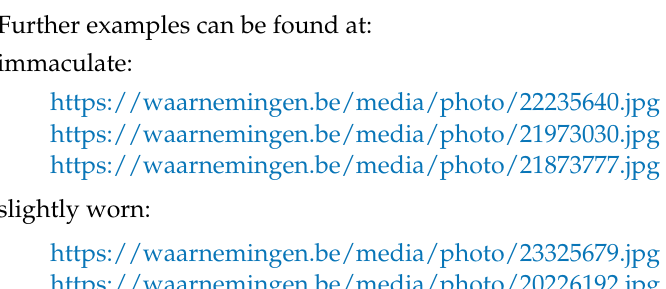
Figure A1. Enlarged Figure 1a,b: white arrows indicating little scratches on the wing.